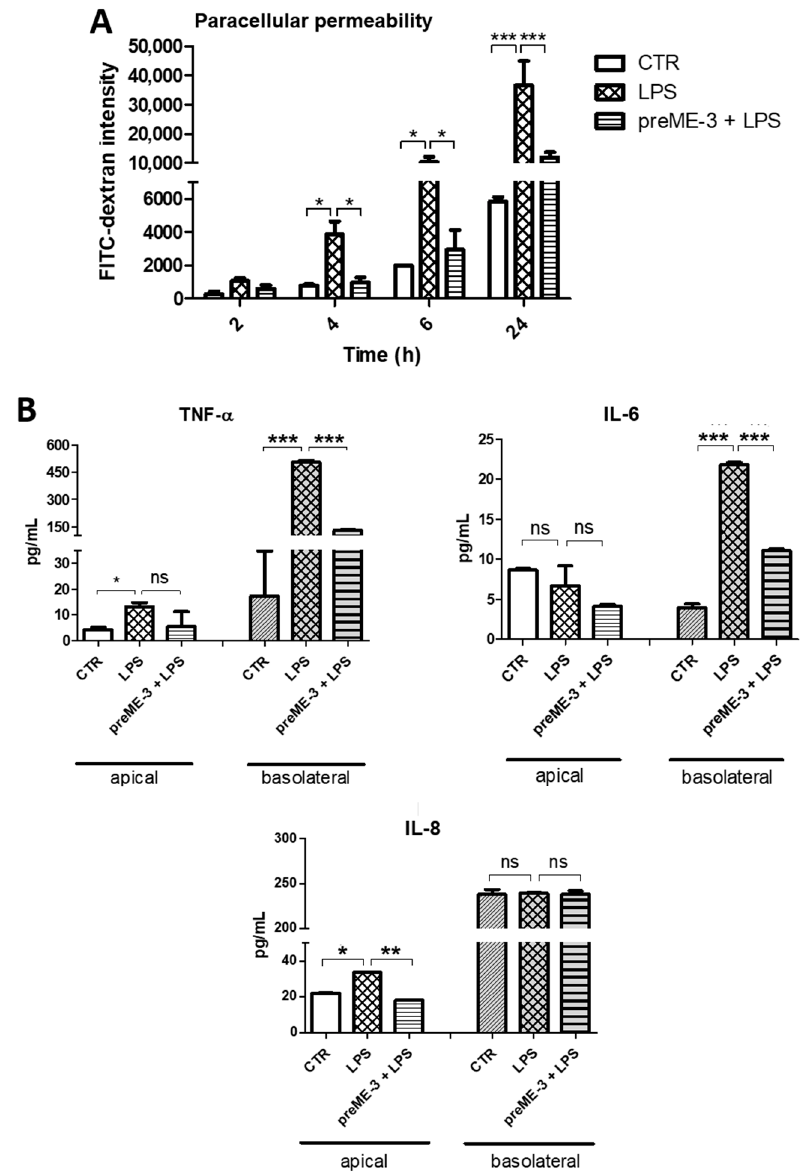
Figure 5. Effects of L. fermentum ME-3 ® on permeability and cytokine production in Caco-2/U937 co-cultures. ( A ) Time course of dextran flux across Caco-2 monolayer cells pretreated or not with ME-3 ® (10 7 CFU/mL) in LPS-inflamed Caco-2/U937 co-cultures. (FITC)-4kDa dextran was added to the apical chamber, and the fluorescence intensity of the medium in the basolateral chamber was measured at different time points. ( B ) Pro-inflammatory cytokines TNF α (right), IL-6 (middle), and IL-8 (left) in the apical or basolateral medium collected from the inflamed Caco-2/U937 co-culture chamber (see Materials and Methods). Values are expressed as the means of three separate experiments ± SDs: * p < 0.05, ** p < 0.01, *** p < 0.001; ns = not significant.